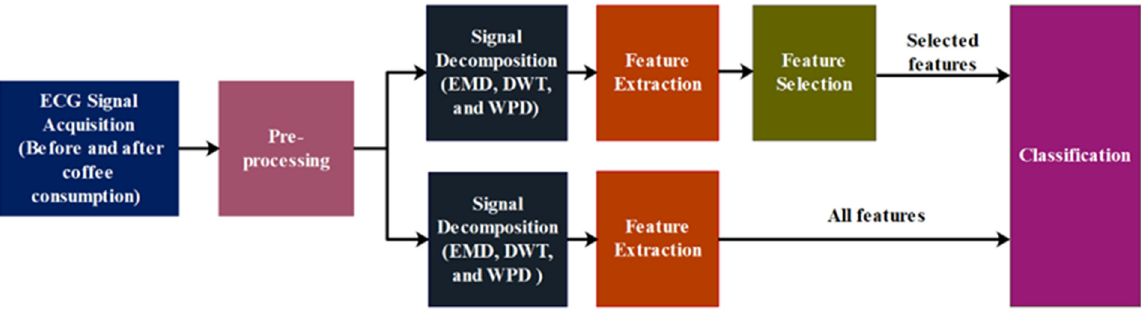
Figure 1. Overview of the proposed model.